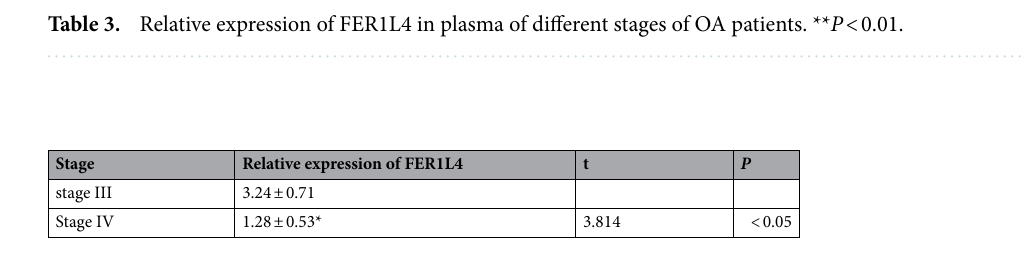
Table 4. Relative expression of FER1L4 in synovial fluid from different stages of OA patients.